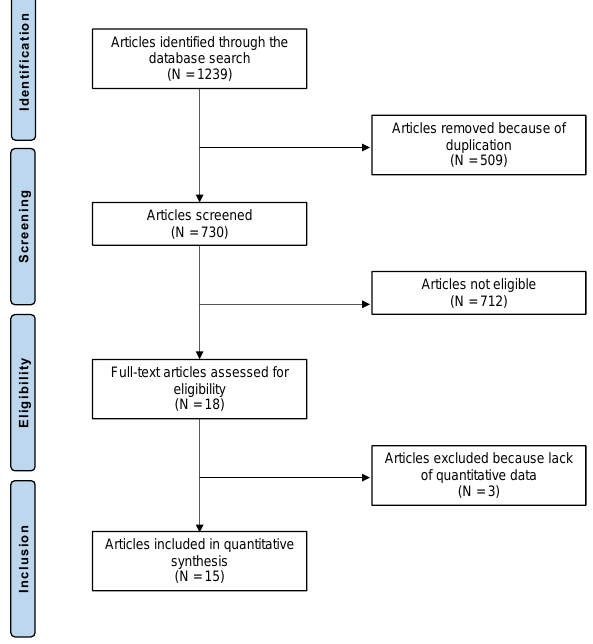
Figure 1. PRISMA flowchart of the literature search.